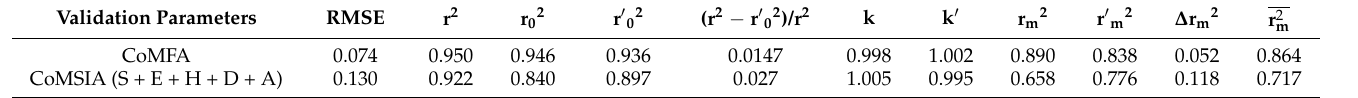
Table 3. External validation parameters of the CoMFA and CoMSIA models.